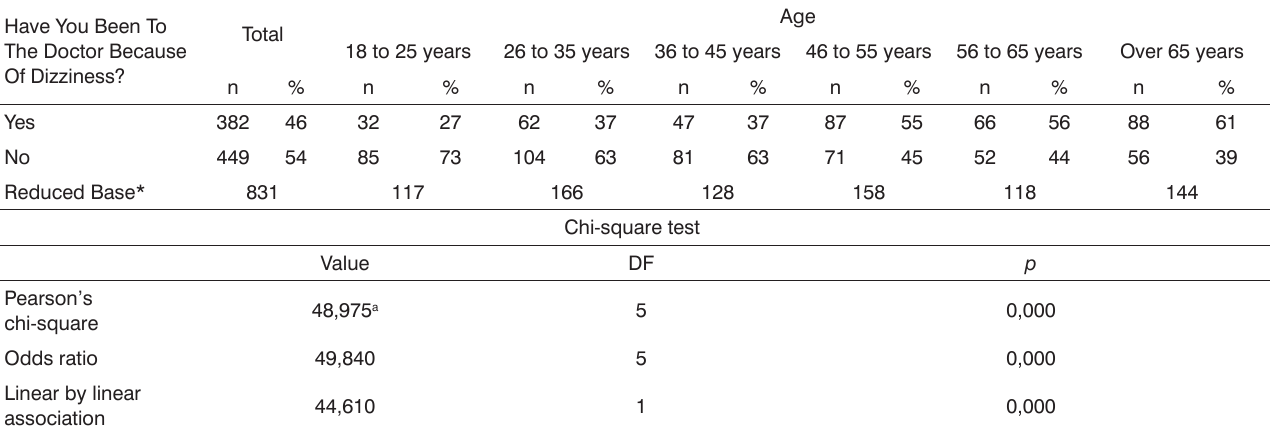
Table 6. Medical consultation for complaints of "feeling dizzy" (n = 831) according to age groups in the population of the city of São